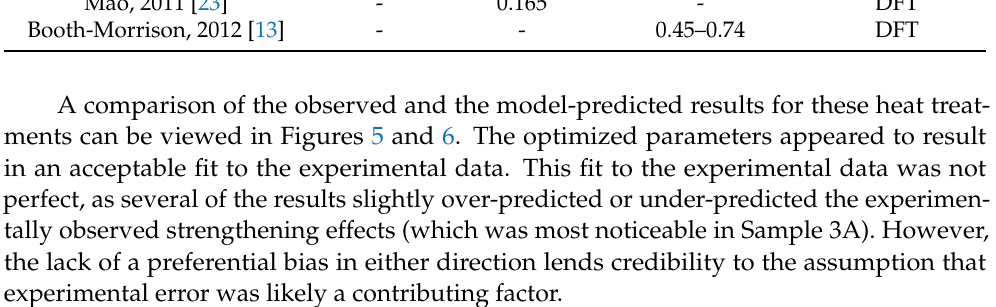
Table 2. Heat ‐ treatment parameters of calibration experiments.